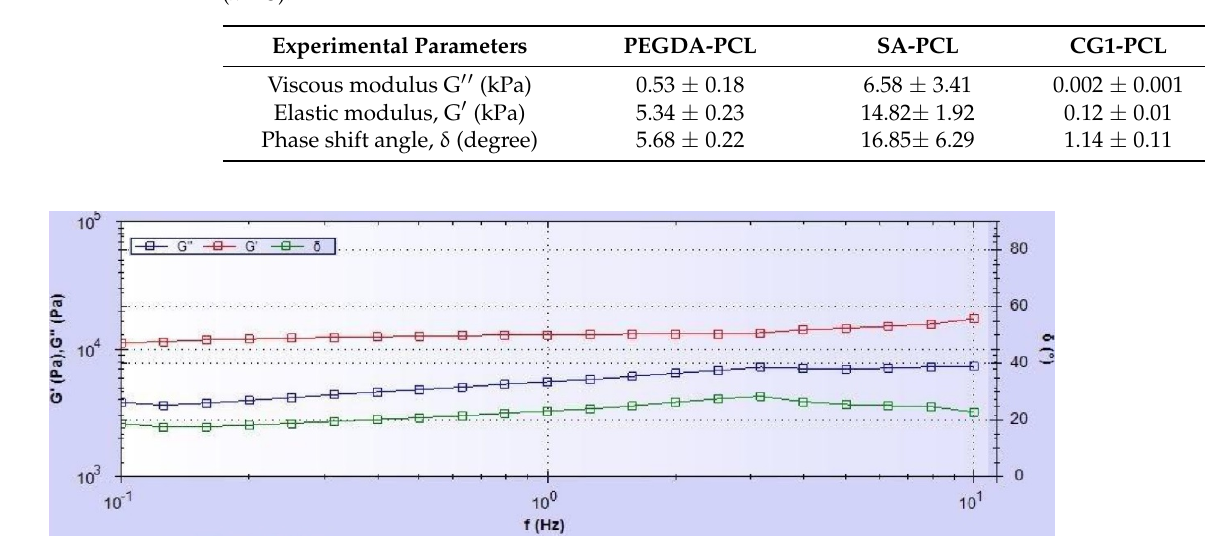
Table 1. Difference between viscoelastic properties between PEGDA-PCL, SA-PCL and CG1-PCL ( n = 3).